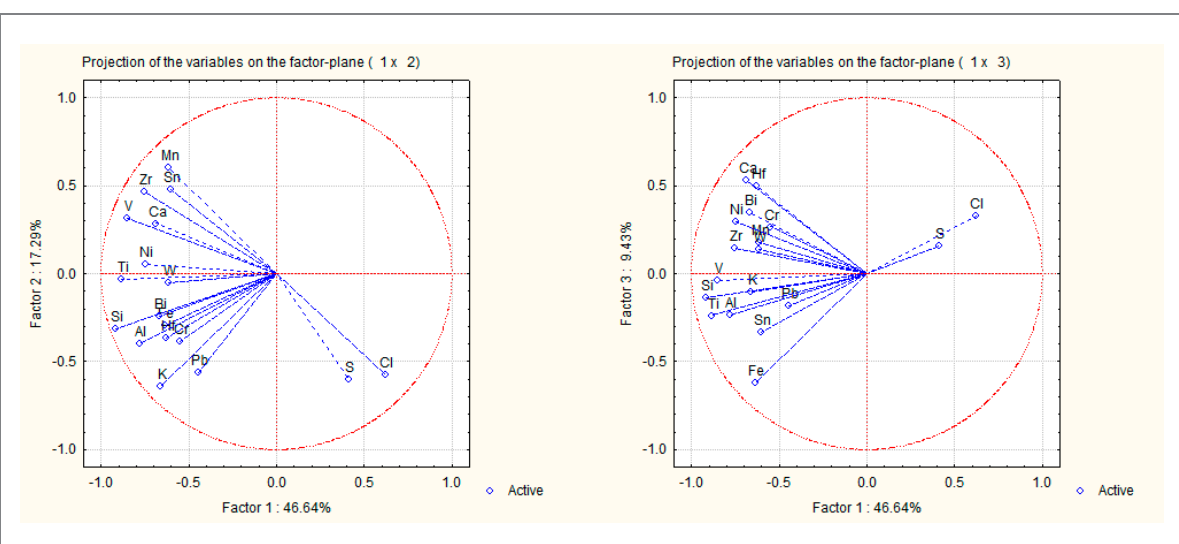
Figure 10 - Principal Component Analysis of the contents of elements of pelagic sediments of the continental margin of the Ceará State,